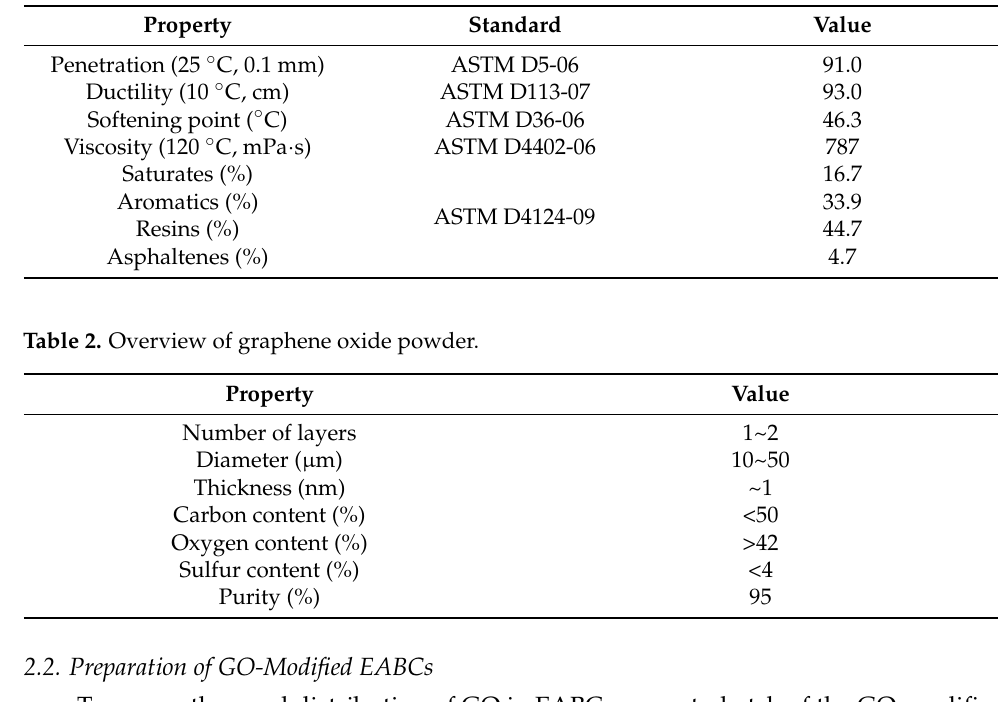
Table 1. Overview of base asphalt.